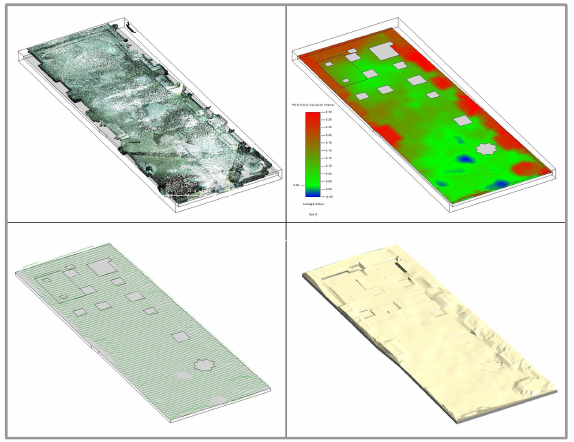
Figure 10. From the point cloud to the deformed floor in BIM environment